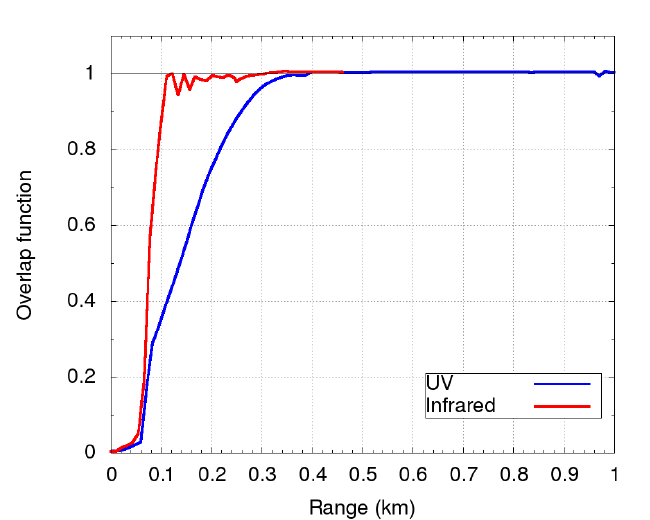
Figure 6. Overlap functions of the receiver and the transmitters at 355nm (blue) and 1064nm (red). The blue curve is based on the average of 13 nighttime measurements up to 1km above the ground. The red curve is based on daytime measurements and obtained under the assumption of the vertical homogeneity of the aerosol concentration below 0.5km above the ground. Both were smoothed using a running average over five consecutive range bins.